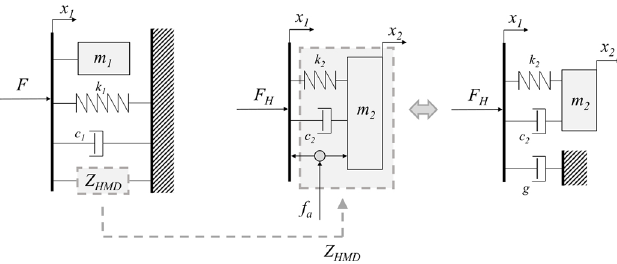
Fig. 2. (a) Parallel representation of the global system, (b) Schematic of the hybrid device and (c) its equivalent mechanical